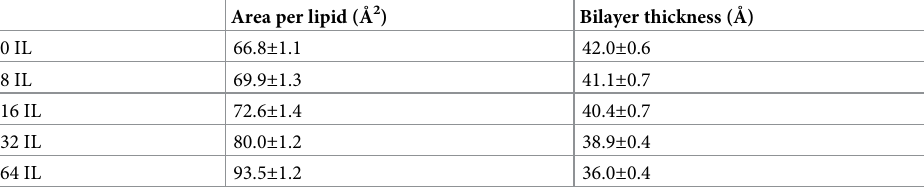
Table 3. Effect of CAGE concentration on POPE area per lipid and bilayer